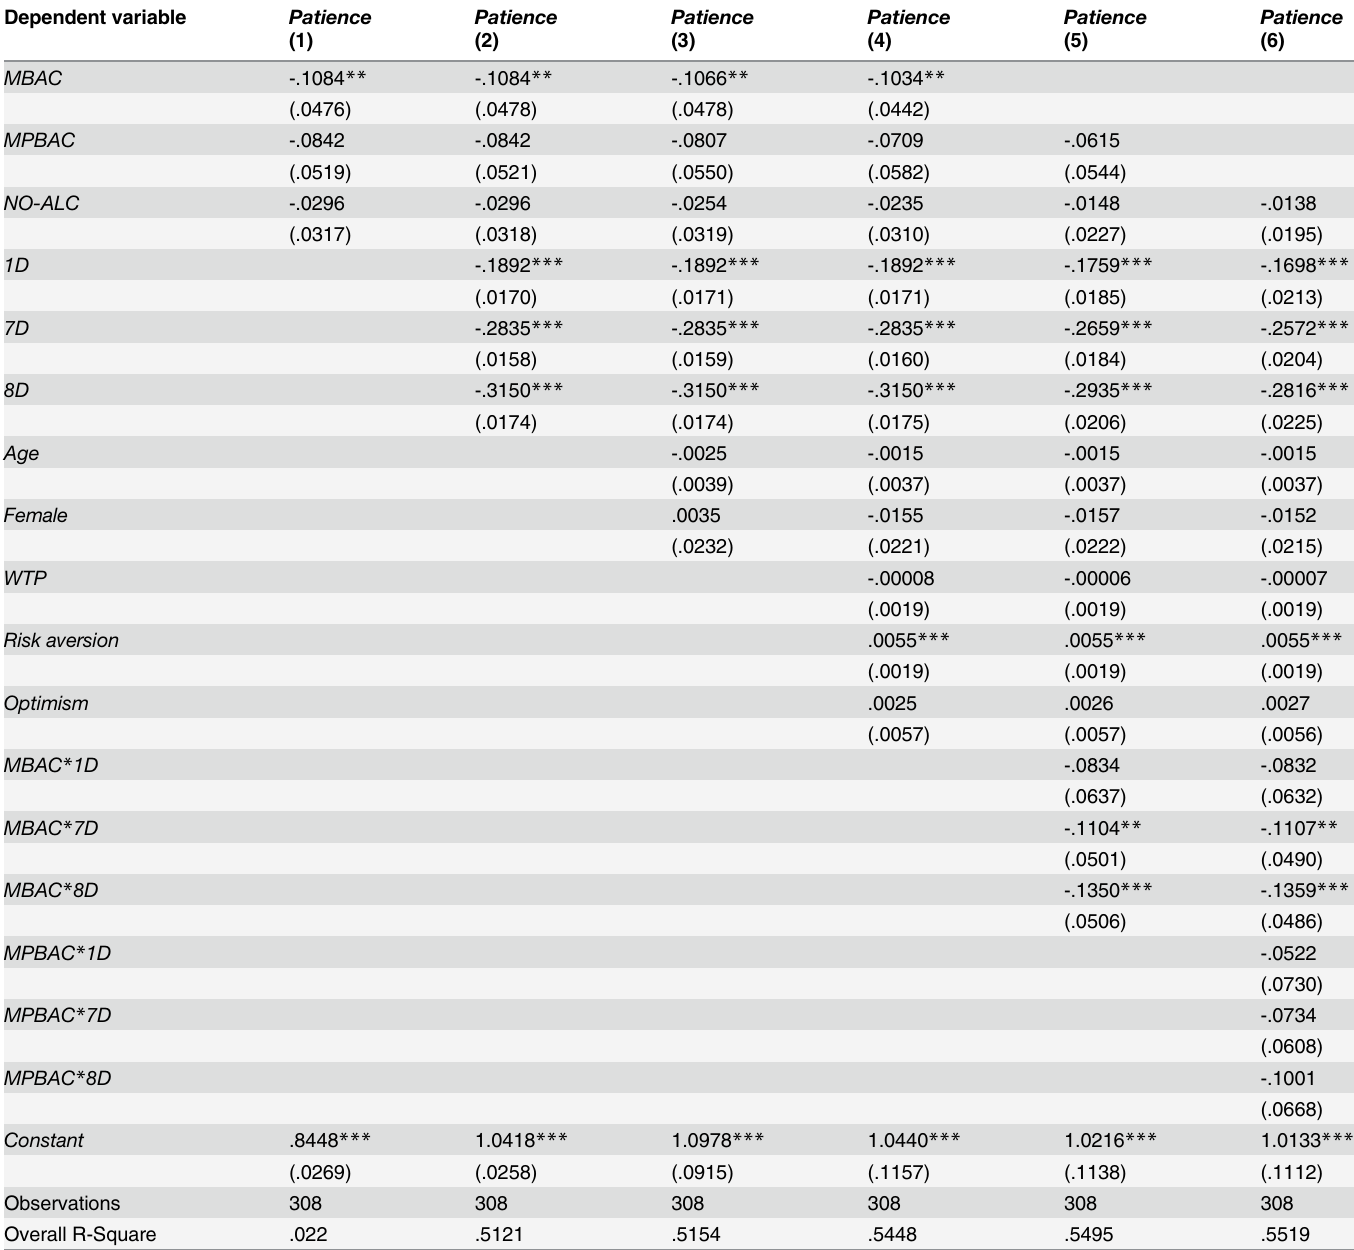
Table 6. Alcohol and Time Discounting,